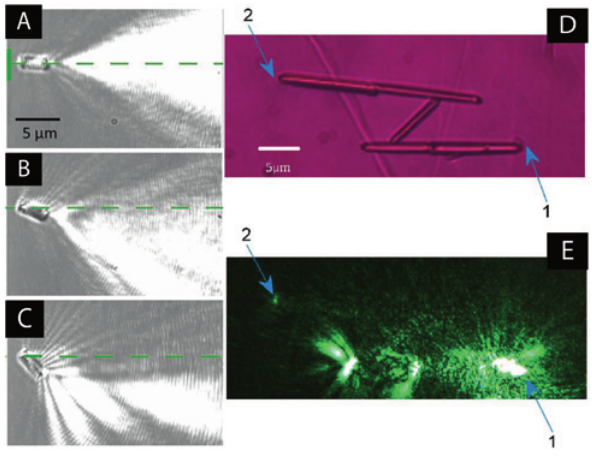
Figure 9: Optical waveguides assembled using optical tweezers. (A – C) Optical microscope images of a zeolite L crystal guiding a 532 nm laser. As the zeolite L crystal is rotated, the output light is redirected parallel to the crystal axis. Reprinted with permission from Ref. [142]. (D – E) Assembled structure consisting of ZnO nanowires. A light source illuminates the structure at point 1 and propagates through the nanowires to point 2, as shown in (E). Reprinted with permission from Ref.